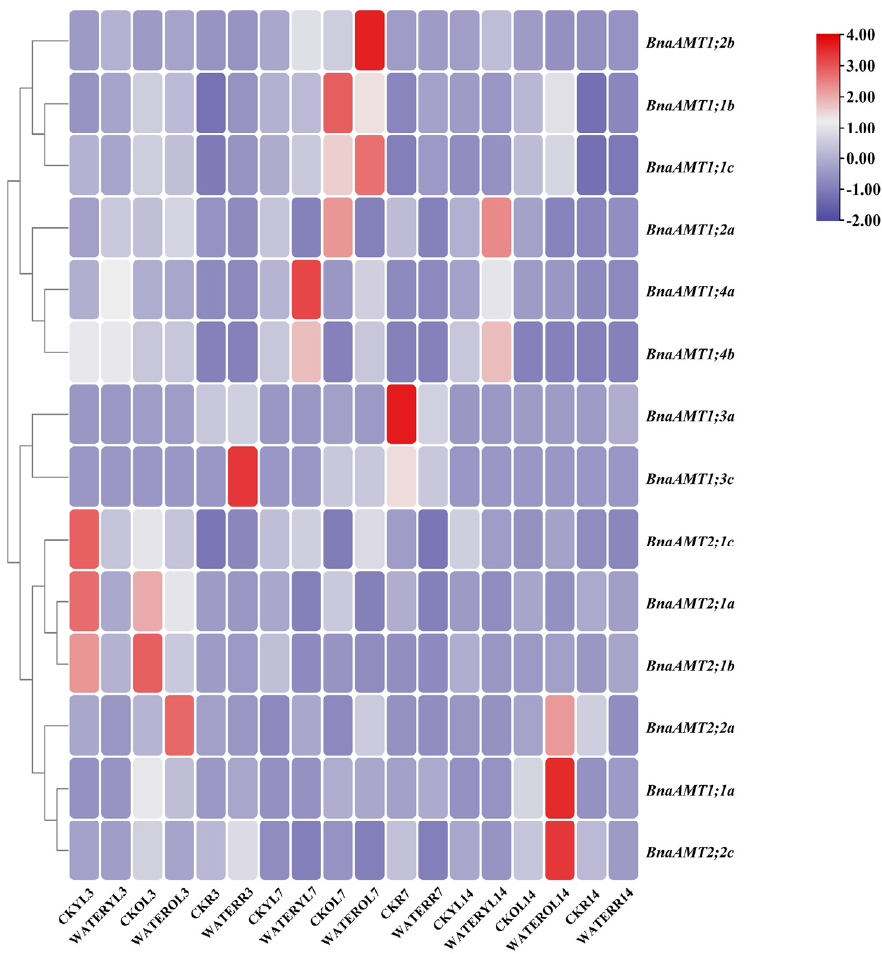
Figure 7. The relative expression profiles of BnaAMT family gene responses to waterlogging stress. CK, control treatment; WATER, waterlogging stress treatment; YL, young leaf; OL, old leaf; R, root; 3, after 3 days of treatment; 7, after 7 days of treatment; 14, after 14 days of treatment. The red color indicates upregulation, while the blue color indicates downregulation. The relative expression levels of BnaAMTs were relative to the control ( actin 7 ). Four biological replicates were performed.